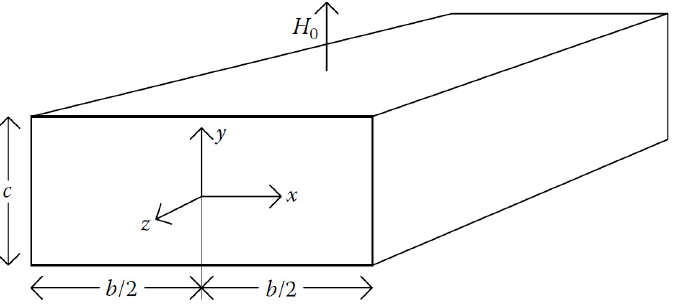
Figure 8. Magnetic flux in the location of the winding conductor.